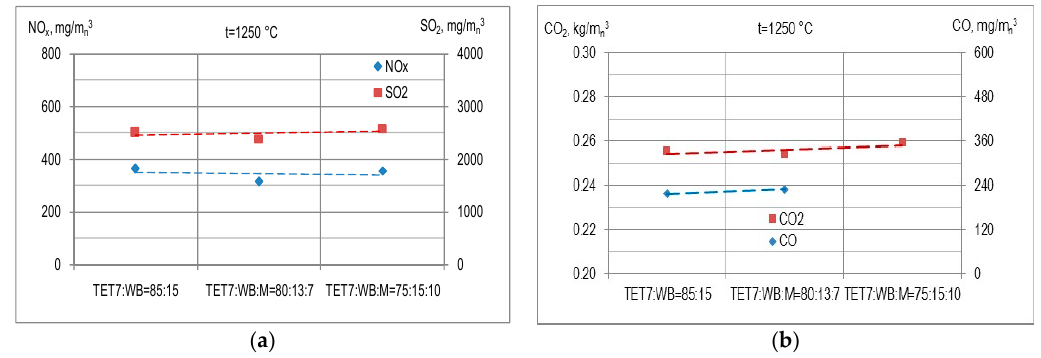
Figure 5. Emissions for different biomass co-firing with coal TET7, ( a ) NO x and SO 2 emissions ( b ) CO and CO 2 emissions.